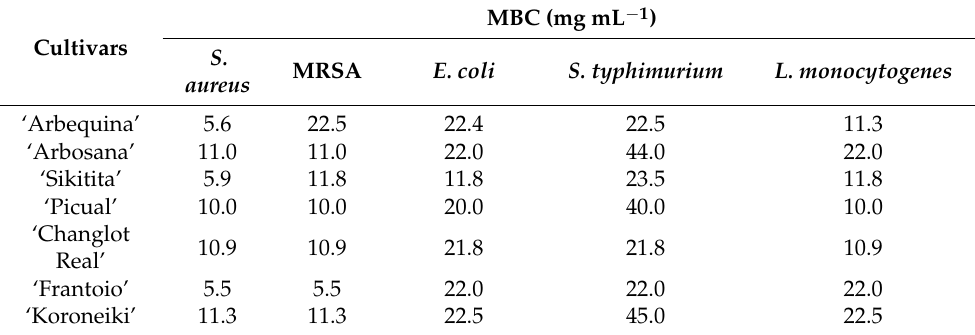
Table 7. Minimum bactericidal concentration (MBC) values (mg mL − 1 ) for olive leaf extracts against bacterial